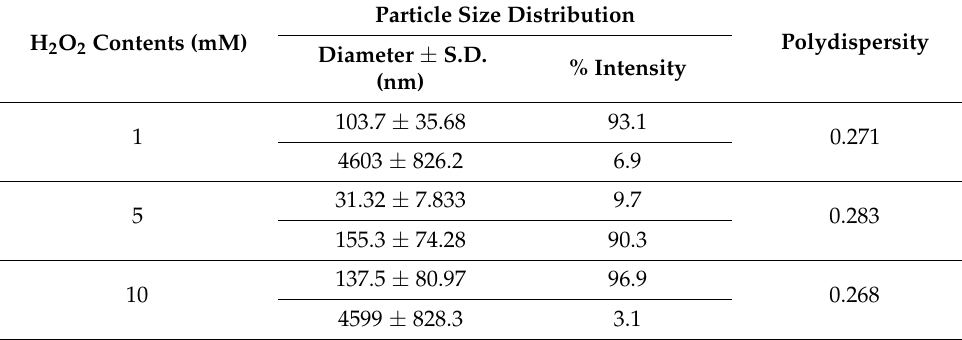
H 2 O 2 Contents